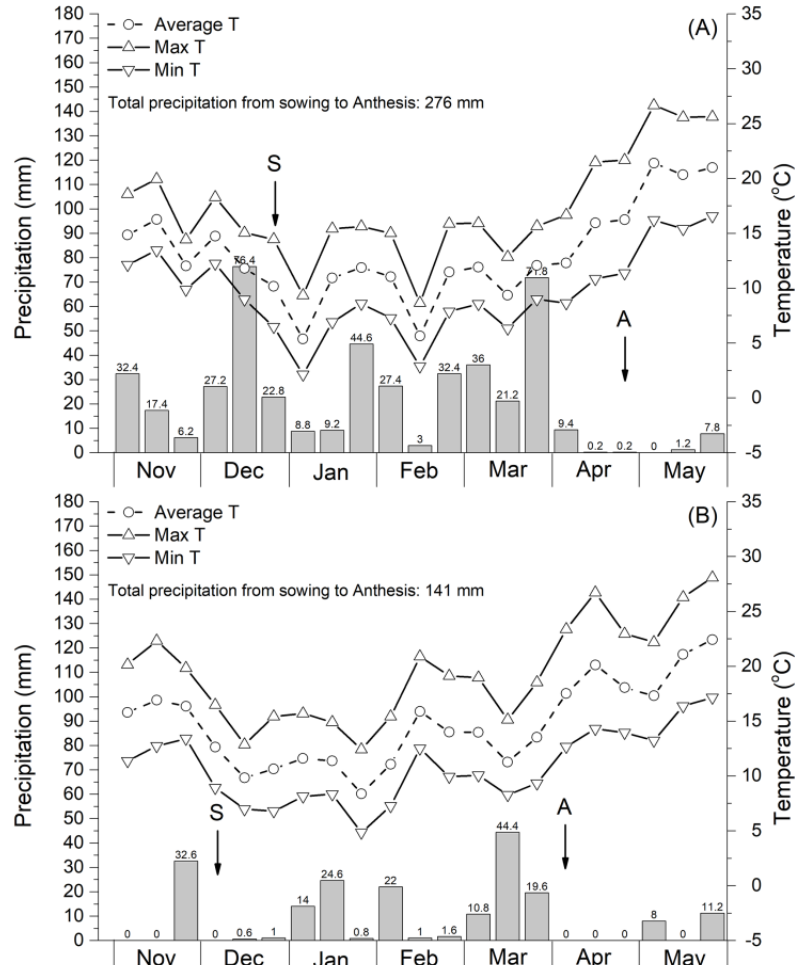
Figure 2. Precipitation and air temperature (Tmin and Tmax) during Exp 1 ( A , 2014–2015) and Exp 2 ( B , 2015–2016). The arrows indicate the main phenological stages: S = sowing; A = anthesis.